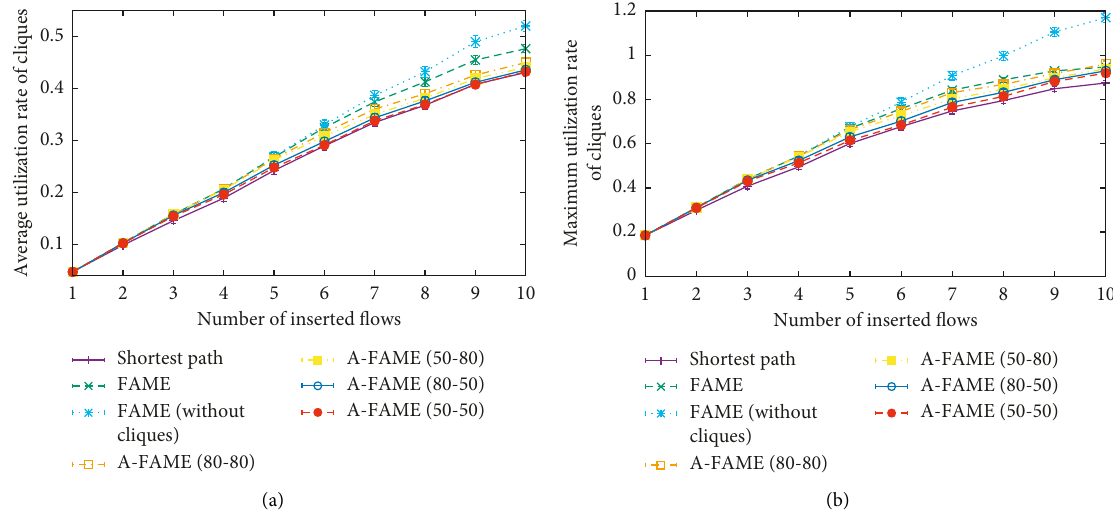
Figure 10: Impact of A-FAME parameters on the network load. (a) Average utilization rate of cliques (b) Utilization rate of the most used